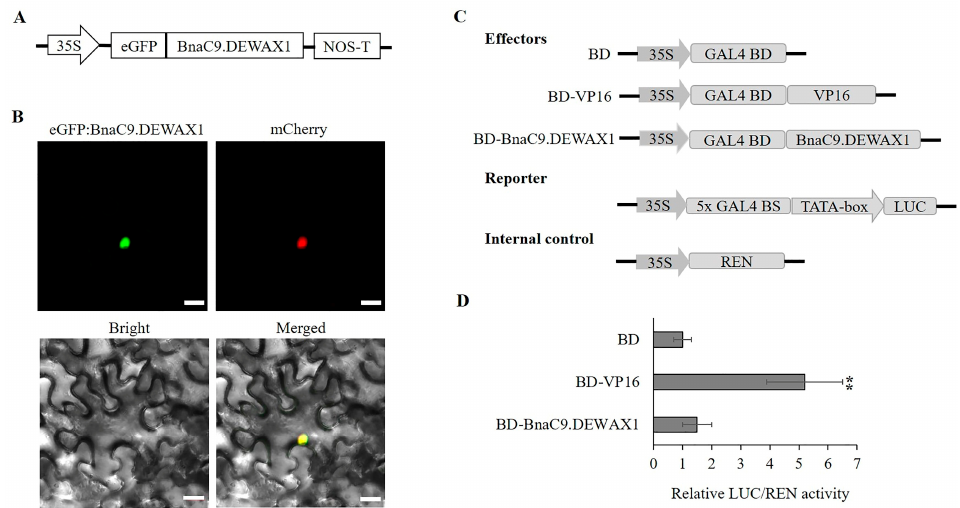
Figure 1. Subcellular localization and transcriptional activity analysis of BnaC9.DEWAX1 in tobacco leaf and Arabidopsis protoplasts. ( A ) Schematic diagram of eGFP:BnaC9.DEWAX1 construct used for Subcellular localization. ( B ) Confocal images of tobacco leaf transient expressing eGFP:BnaC9.DEWAX1. The nuclear marker mCherry-D53 was used as a positive control. Bar = 20 μ m. ( C ) Schematic diagram of effector and reporter constructs used for the BnaC9.DEWAX1 transcriptional activity assay. BD—GAL4 DNA-binding domain. VP16—herpes virus protein VP16 activation domain. ( D ) Transcriptional activity assay of BnaC9.DEWAX1 in Arabidopsis leaf